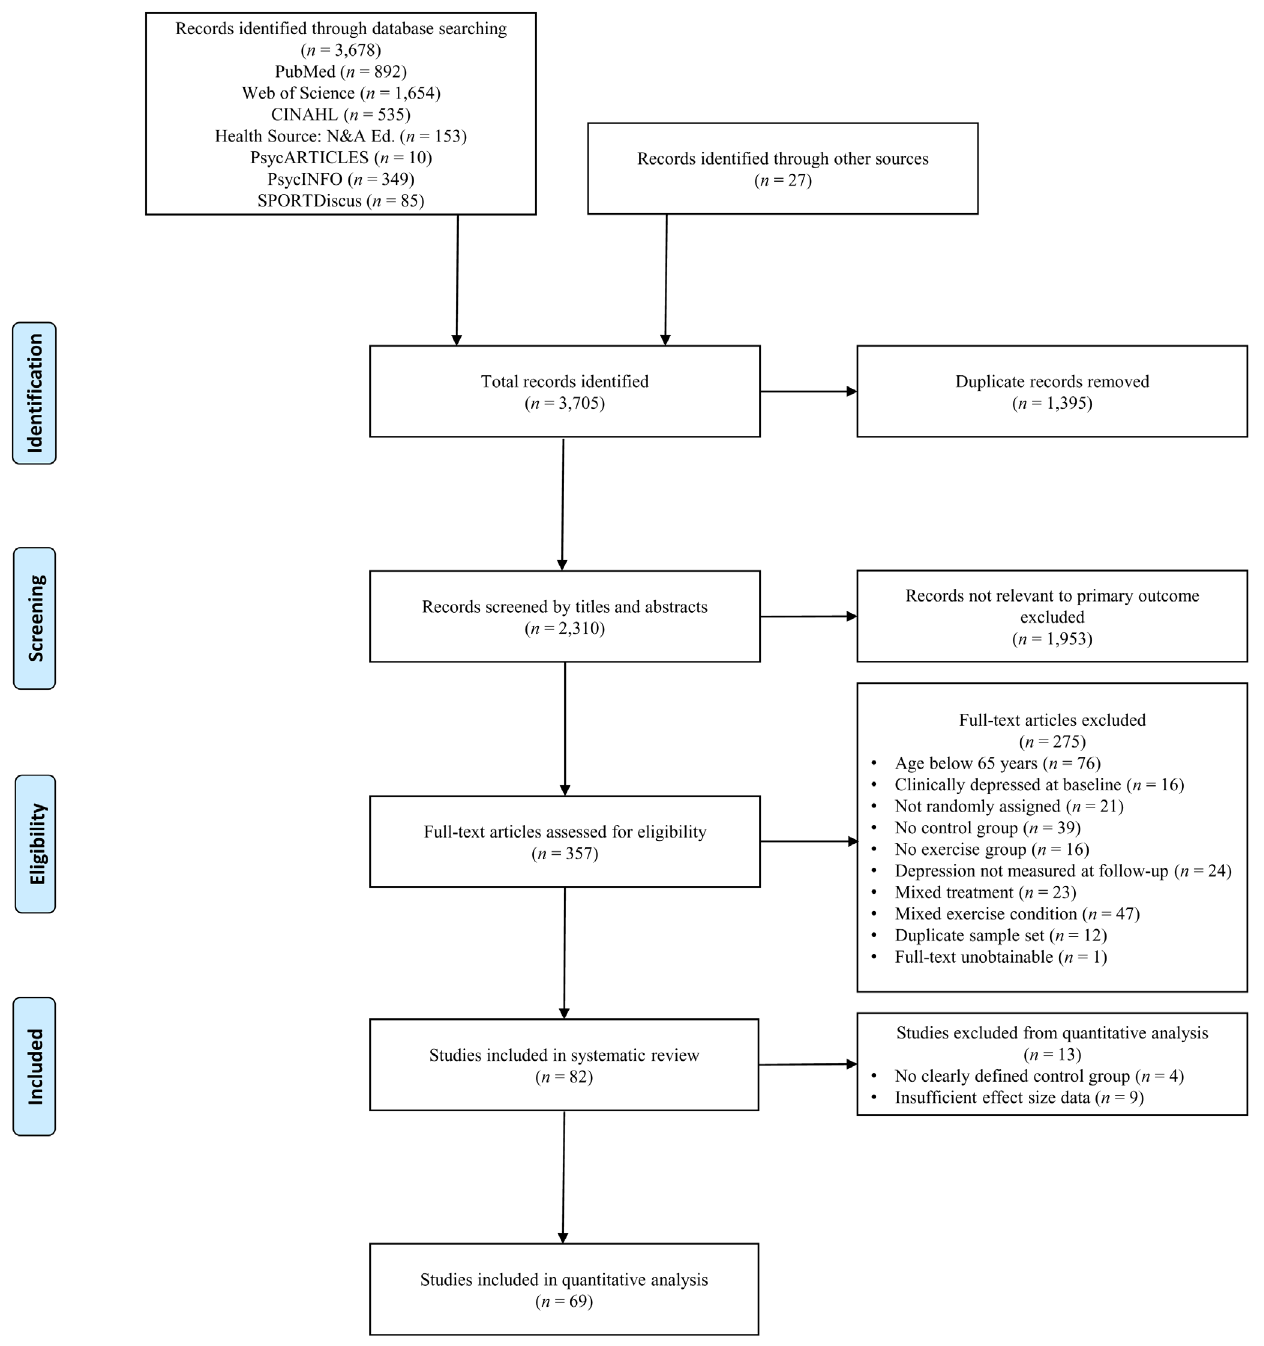
Figure 1. Flowchart of screening process.